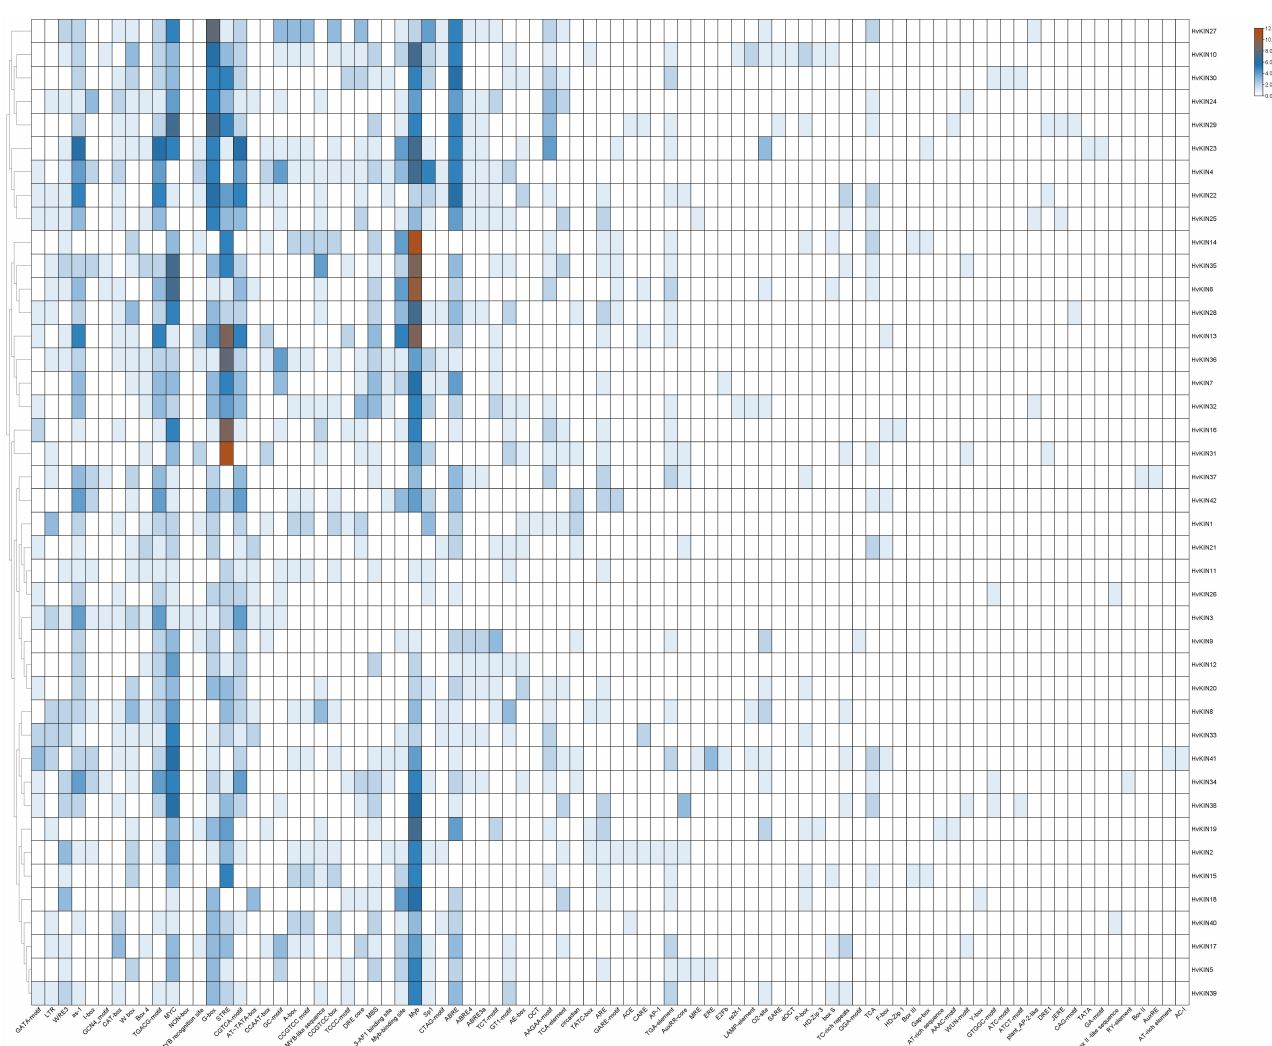
Figure 5. Cis-acting element structures in promoter regions of barley HvKIN family